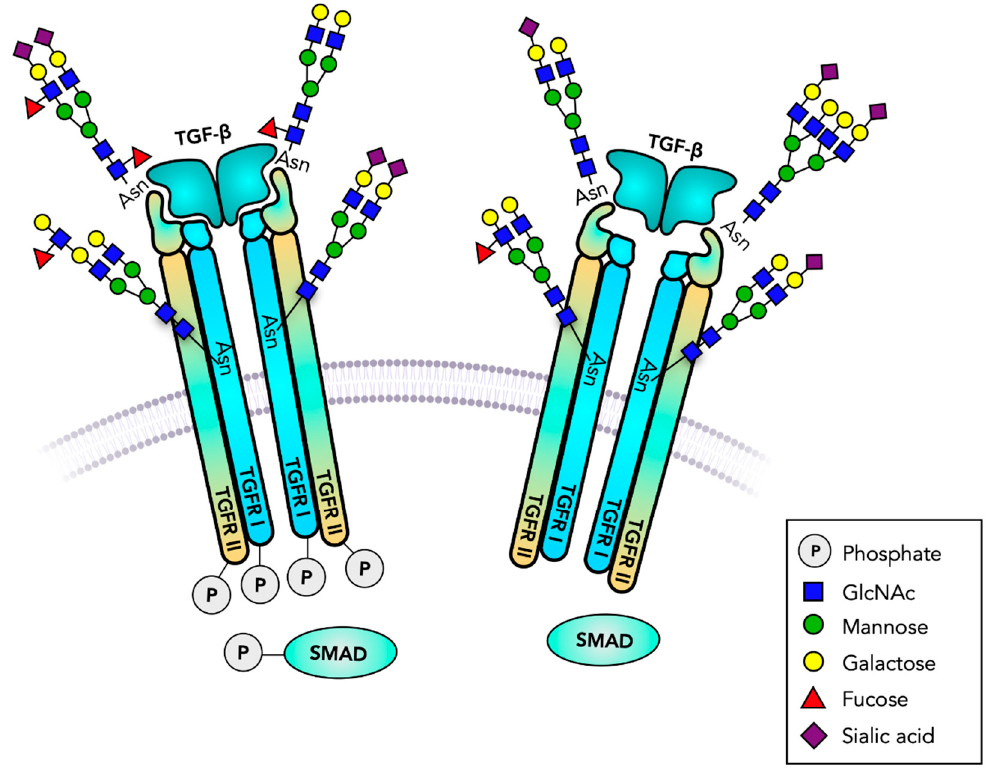
Figure 3. TGF- β receptors are serine/threonine kinases. Transforming growth factor receptors (TGFR) are heterodimeric transmembrane receptors that form tetrameric transmembrane receptors. Binding to TGF- β initiates intracellular ser- ine/threonine phosphorylation, cell proliferation, differentiation and many other biological responses. The signaling cascades and gene regulation involve SMAD phosphorylation. TGFR has several functionally important N -glycans, and may carry glycosaminoglycans and O -glycans. A Fuc residue at the N -glycan core plays a major role in receptor function. Truncated, GPI-anchored, receptor analogs regulate the binding of TGF- β . Table 4. Transforming growth factor receptors.